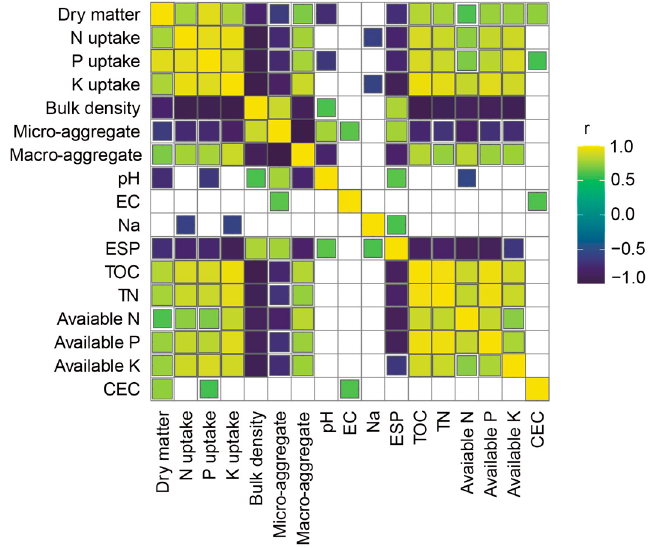
Figure 3. Correlation matrices between maize productivities and soil properties across all the treatments as revealed by Pearson’s rank correlation analysis. All squares represent p < 0.05.